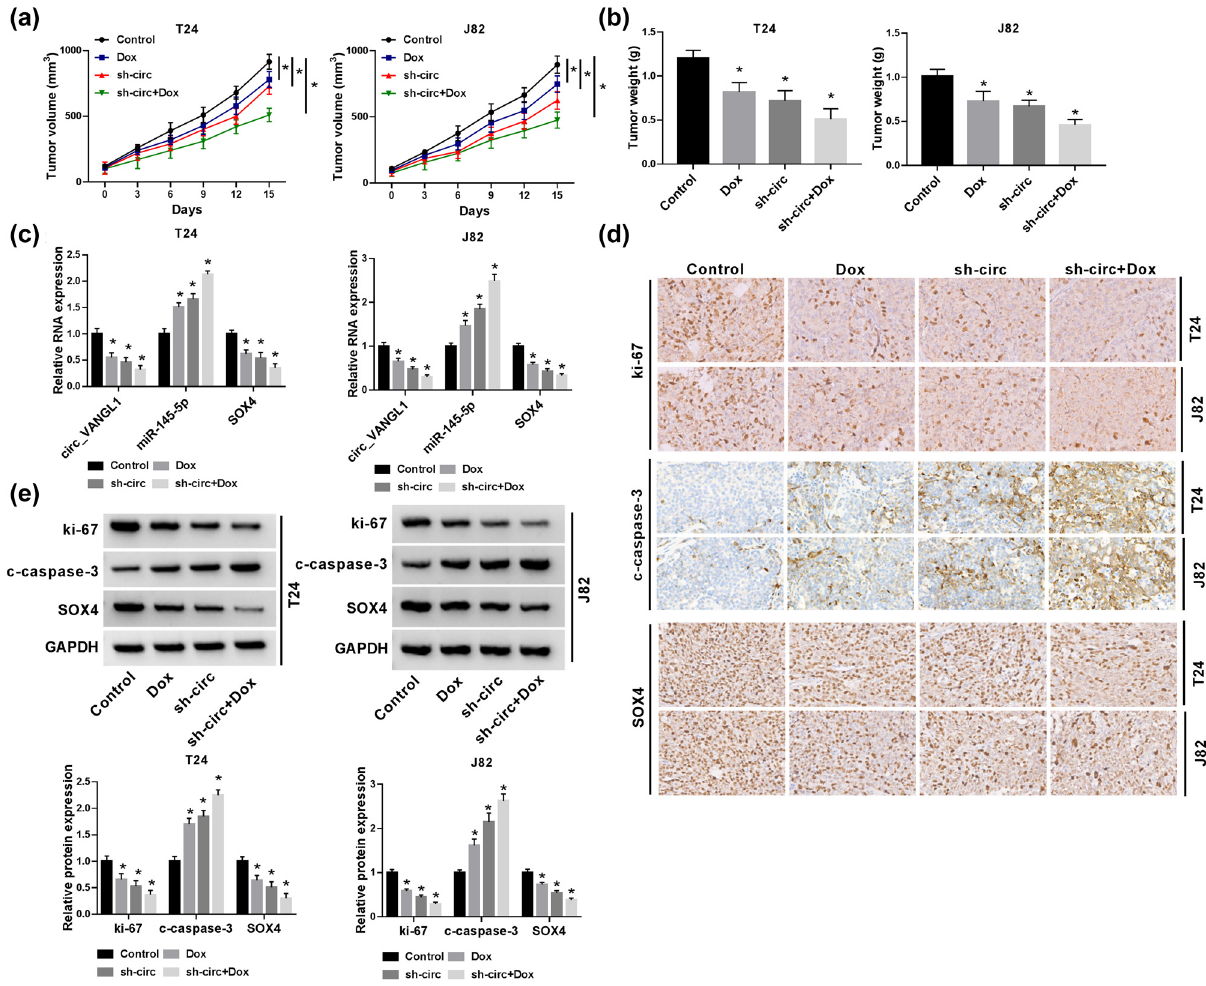
Figure 7: circ_VANGL1 knockdown inhibited tumor growth and enhanced doxorubicin sensitivity in vivo . T24 and J82 cells stably transfected with sh - circ or T24 and J82 cells were subcutaneously injected into the forelimb axils of nude mice, followed by the injection of doxorubicin ( 3 mg/kg ) every 3 days. Fifteen days upon injection, the mice were killed to remove the tumor tissues. ( a ) Tumor volume was detected every 3 days for 15 days. ( b ) Tumor weight was measured. ( c ) The expressions of circ_VANGL1, miR - 145 - 5p, and SOX4 in xenograft tissues were determined by RT - qPCR. ( d ) Proliferation in xenograft tumors was assessed by Ki67 Immunohistochemistry. ( e ) The protein levels of